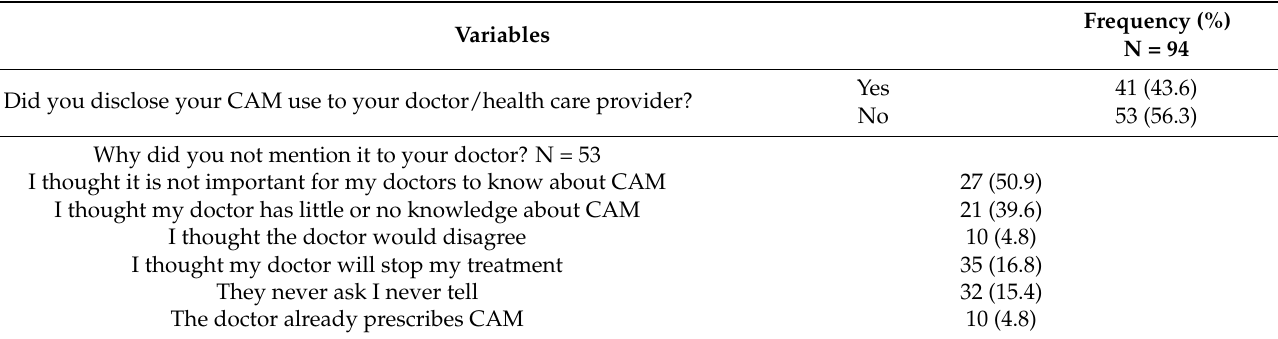
Table 5. Participants CAM use disclosure and reasons for non-disclosure to